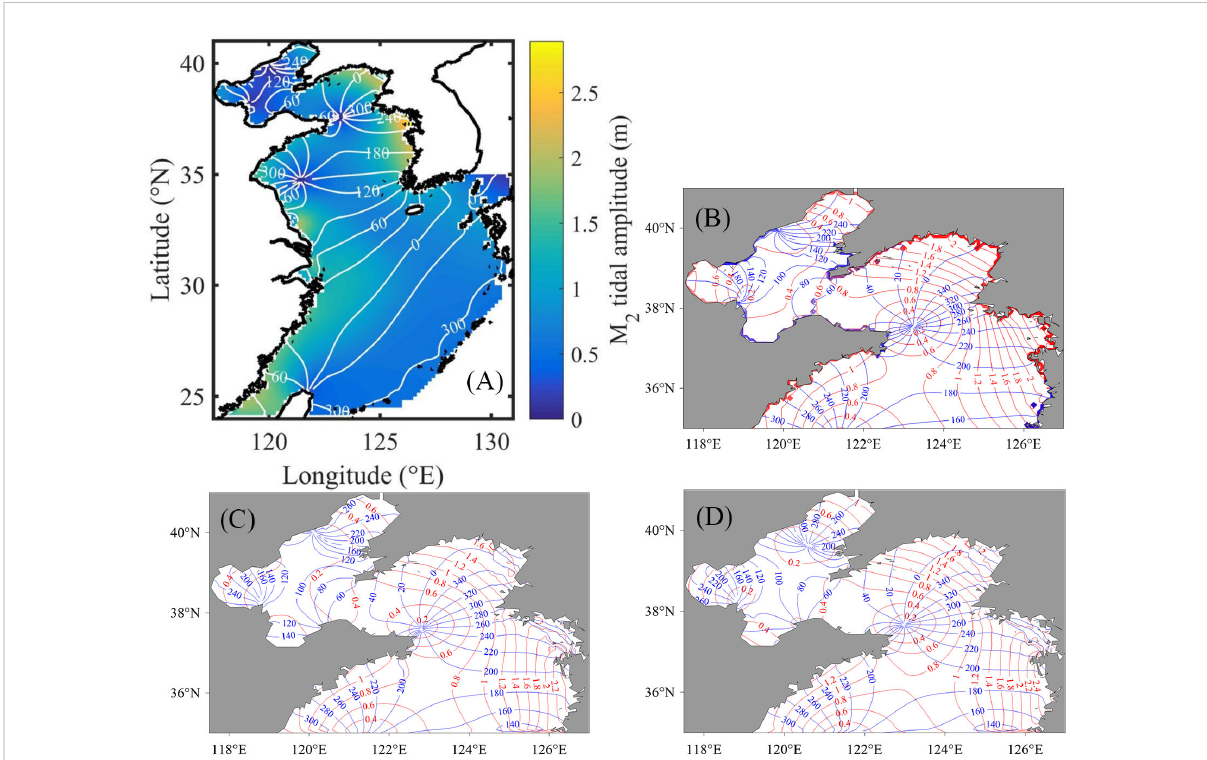
FIGURE 6 (A, B) are the cotidal charts from Wang et al. (2021) and the National Astronomical Observatory (NAO) data, respectively. (C, D) are the cotidal charts before and after data